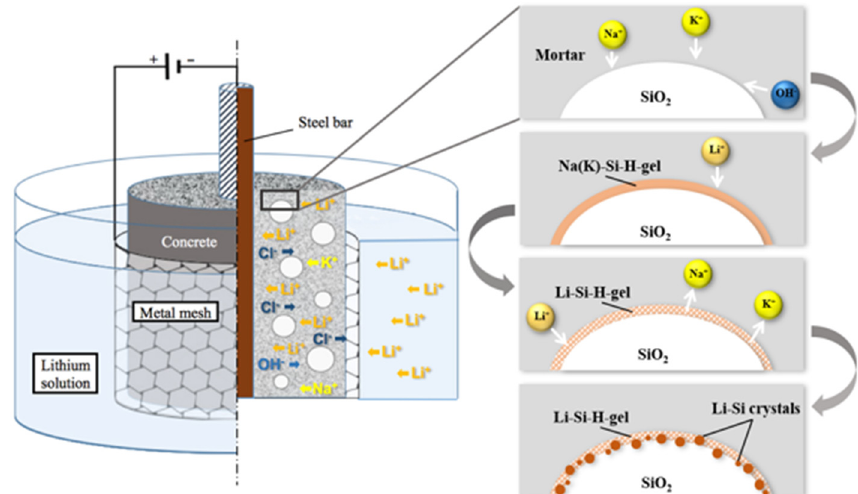
Figure 11. Schematic diagram of the mechanism of ELM ‐ ECR method for ASR mitigation and chloride